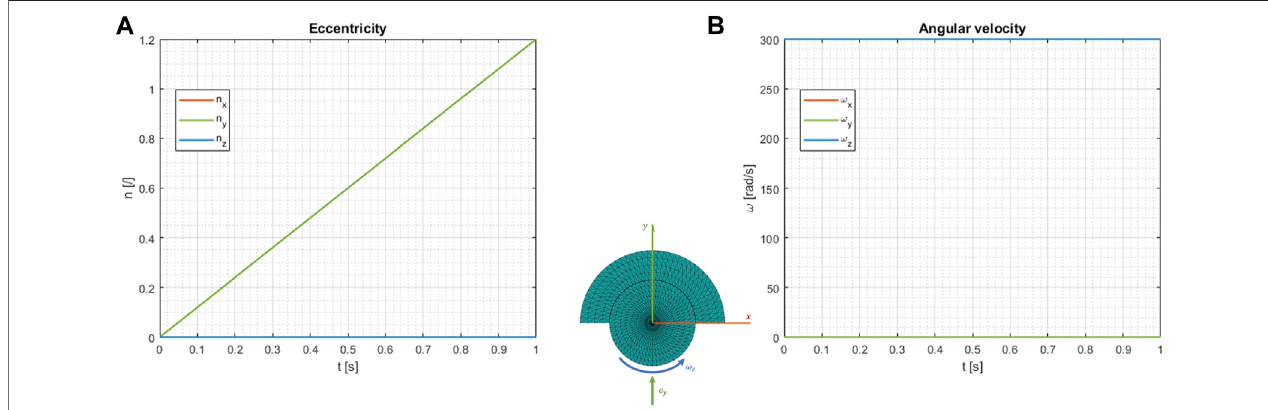
FIGURE 5 | Spherical joint kinematics input: eccentricity (A) ; angular velocity (B) .